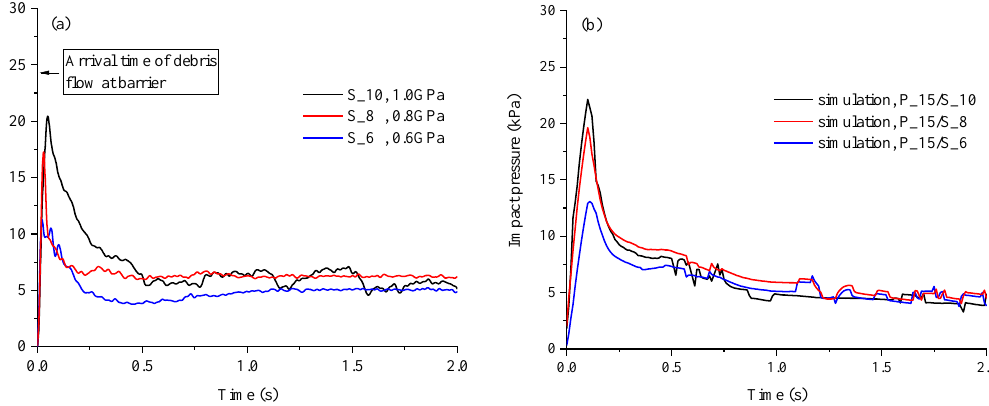
Figure 4. Histories of the tested ( a ) and simulated ( b ) impact forces for different values of barrier stiffness.